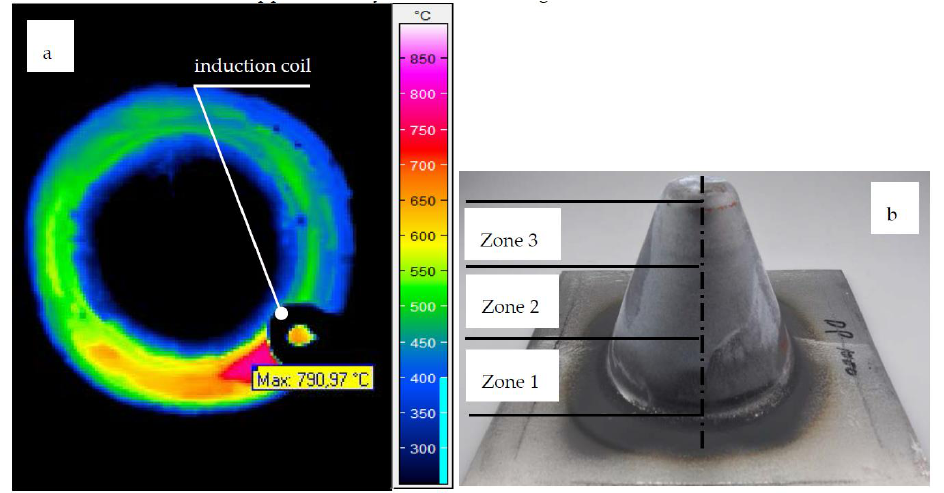
Figure 7. ( a ) Thermographic image taken by IR camera showing the inductor and the heat generated during induction heating and forming; and the ( b ) formed cone from HCT980C steel divided into three zones.